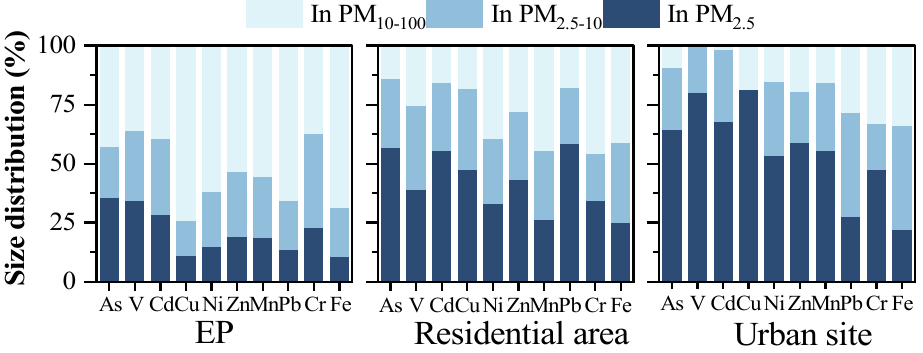
Figure 2. Size distribution of metals in e-waste dismantling park (EP), residential area (geomean of S1~S18), and one urban site.